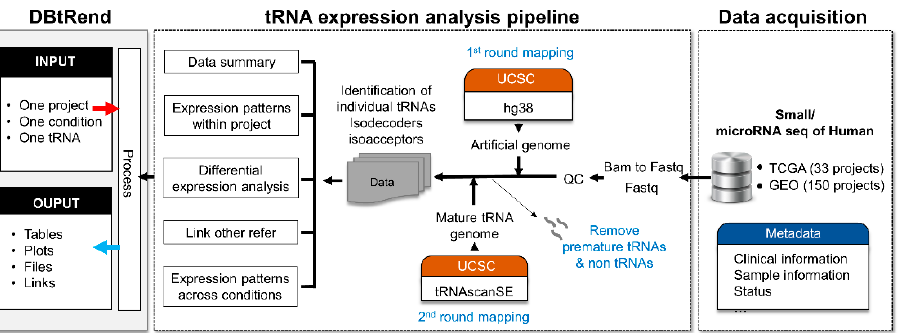
Figure 1. Schematic representation of the data processing and workflow of DBtRend construction (https://trend.pmrc.re.kr/, accessed on 10 June 2020). The DBtRend re-analyze human small RNA sequencing datasets such as microRNA sequencing datasets from GEO and TCGA. We then calculated the expression of mature tRNAs using a specific pipeline and merged them into the isodecoder and isoacceptor